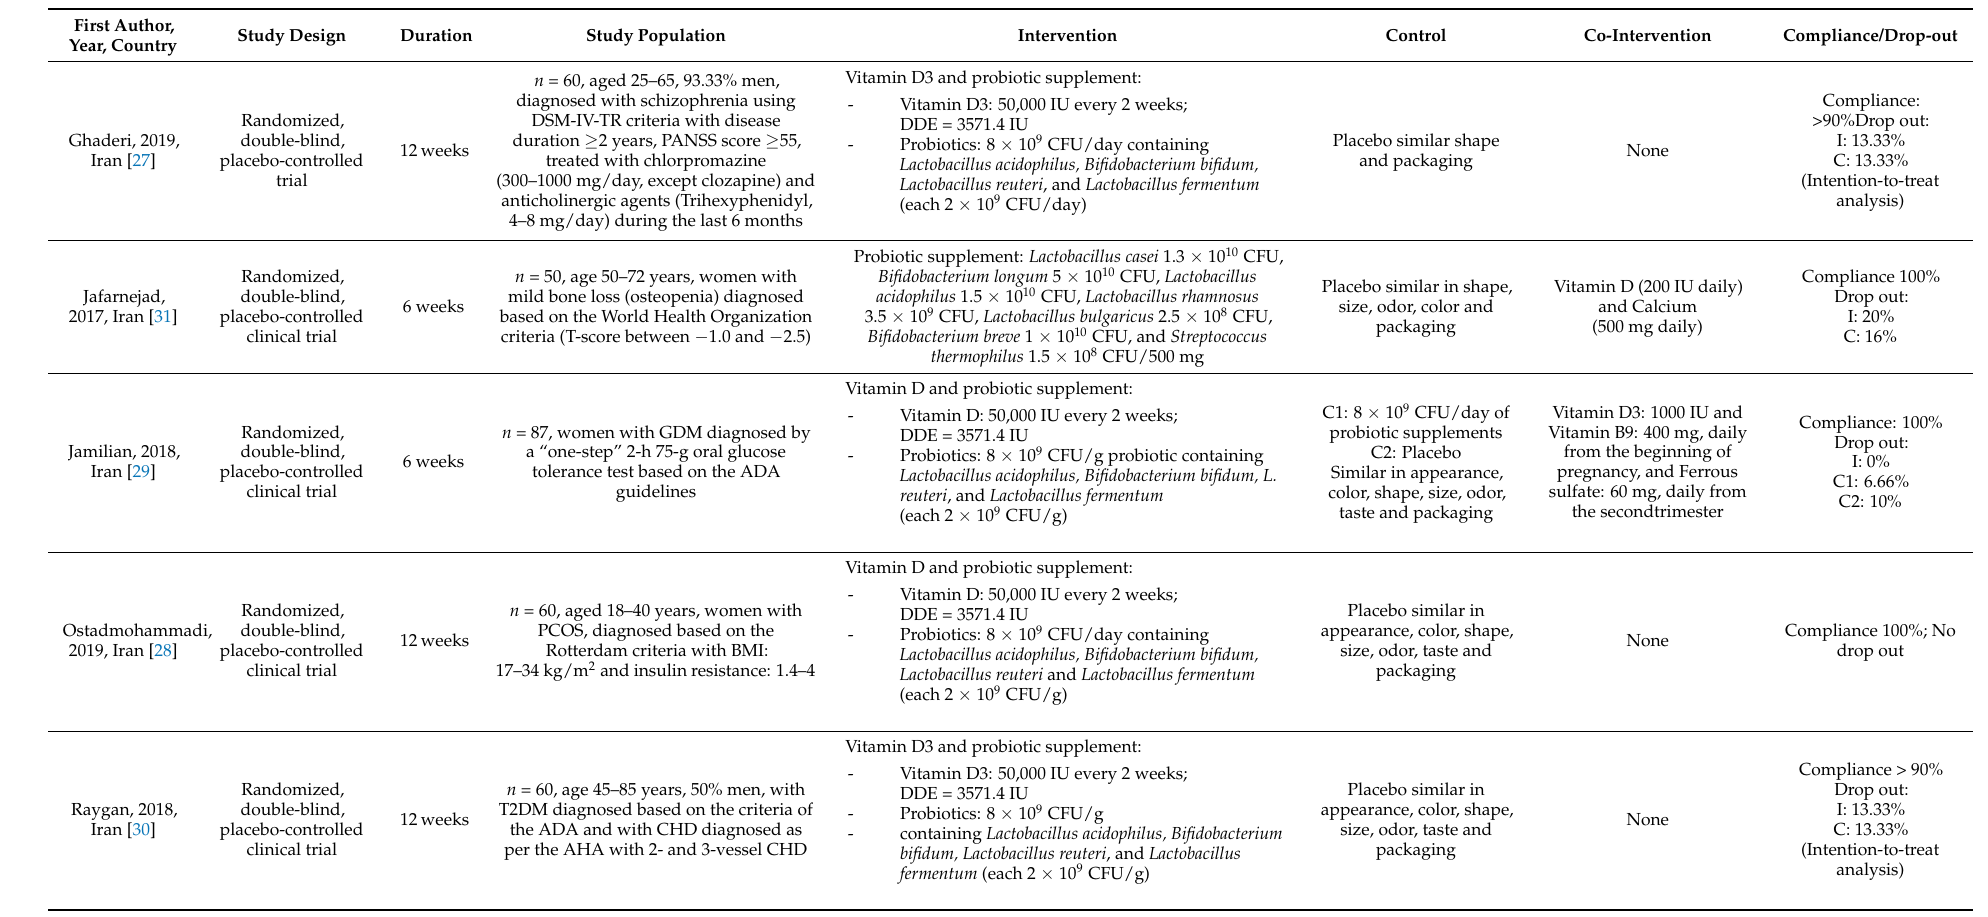
Table 1. Characteristics of included